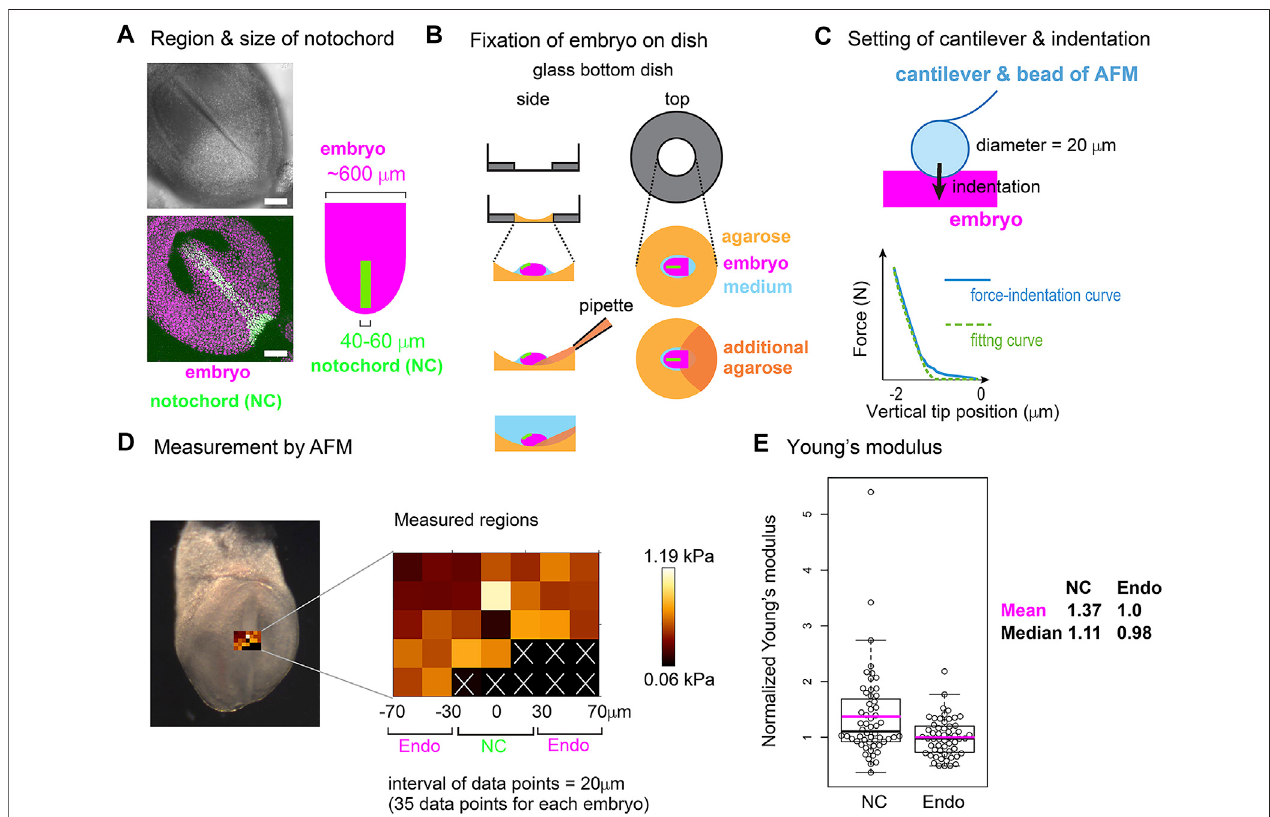
FIGURE 8 | Young ’ s modulus measured using AFM in mouse notochord and endoderm. (A) Microscopic images of a mouse embryo are shown. Nuclei of the notochord cells were labeled with nuclear-EGFP (green), and nuclei of all embryonic cells including the endodermal cells as well as the notochord cells were labeled by histone 2B-mCherry (magenta). Upper panel, bright fi eld; bottom panel, a maximum intensity projection image constructed from confocal fl uorescent images; left panel, illustrationofanembryoandthenotochord.Typicalwidthsofthenotochordandembryoarewritten. (B) PreparationprocedureofembryoforAFMisillustrated.An embryo(magenta) isplacedonanagarosegel(lightorange)inaglass-bottomdish,andapartoftheembryoisoverlaidbyanadditionalagarosegel(darkorange) before medium (blue) is added. Side and top views are shown. (C) AFM cantilever assembly and indentation. A bead of 20 μ m diameter was attached to the cantilever as described in the Materials and Methods section. A force – indentation curve is schematically illustrated with a fi tting curve which is used for calculating the Young ’ s modulus. The x – axis is the depth of indentation. Examples of real force – indentation curves are shown in Supplementary Figure S6 . (D) A spatial map of Young ’ s modulusmeasuredbyAFMisshown.Intheleftpanel,abright fi eldmicroscopicimageisprovidedwheretheregionssubjectedtotheAFMmeasurementarealsoshown. In the middle panel, the Young ’ s modulus for each region in the embryo is shown with a20 μ m spatial interval. In regions marked by whitecrosses, AFM measurements failedtobecarriedout.Theregionsofthenotochordandendodermwereestimatedbythewidthofthenotochord.NC,notochord;Endo,endoderm.Intherightpanel,a colorbarofYoung ’ smodulusisshown. (E) Young ’ smoduliinthenotochordandtheendodermalregionsarecompared.Themeanvalueintheendodermalregionswas setat1.0,andtherelativevalueswereplotted.Fourembryoswithseveraltensofdatapointswereanalyzedwithtotaldatapoints=56inbothNCandEndo.Boxplotsare shown where the boxes extend from the lower to upper quartiles and the whiskers indicate the 1.5 – interquartile ranges. The p -value calculated using the Mann – Whitney – Wilcoxon test was 0.006. Magenta bars, mean; black bars, median; NC, notochord; Endo, endoderm. According to this boxplot, there are two or one outlier(s)located outsideofthewhiskersfor NC andEndo. Whenthese outliersareexcluded,thestatistic valuesbecomeasfollows: mean=1.25 (NC),0.98(Endo), and median = 1.07 (NC), 0.98 (Endo), and p -value = 0.008. The mean values of the four individual embryos (#1 – #4) are as follows (notochord, endoderm), #1 (0.37 [kPa], 0.22), #2 (0.48, 0.36), #3 (0.55, 0.47), and #4 (0.63,